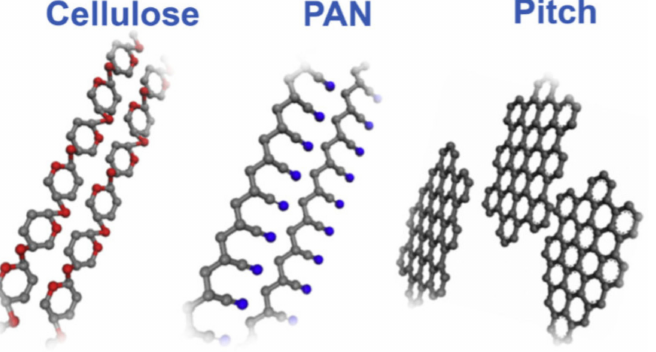
Figure 17. Structures of different precursors of carbon fibers. Reproduced with permission from [80], Elsevier,